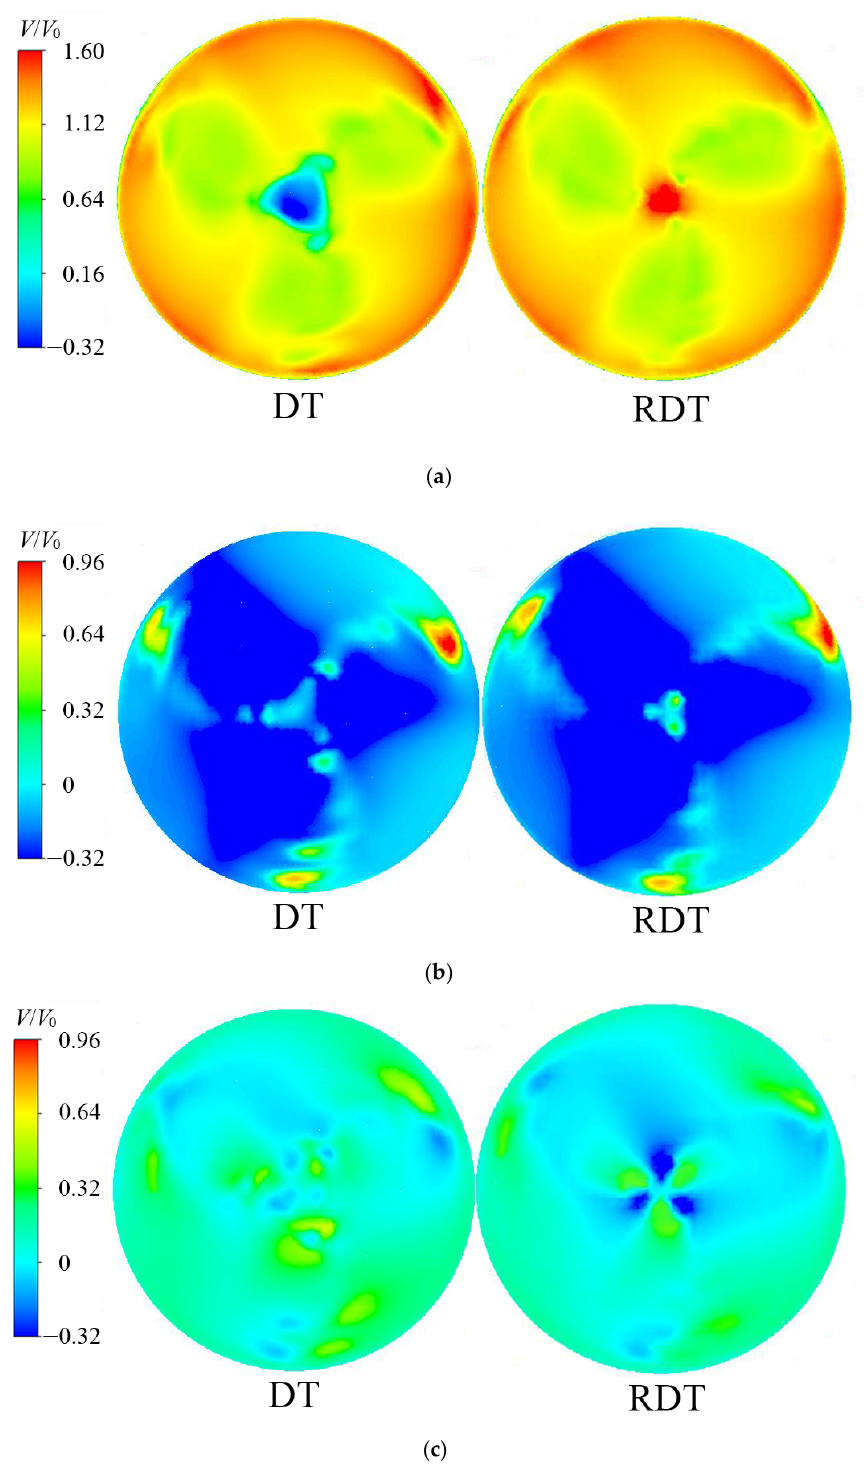
Figure 12. Velocity component contours for the two configurations in the x - y plane of z / D =0.1: ( a ) axial velocity contours; ( b ) tangential velocity contours; ( c ) radial velocity contours.